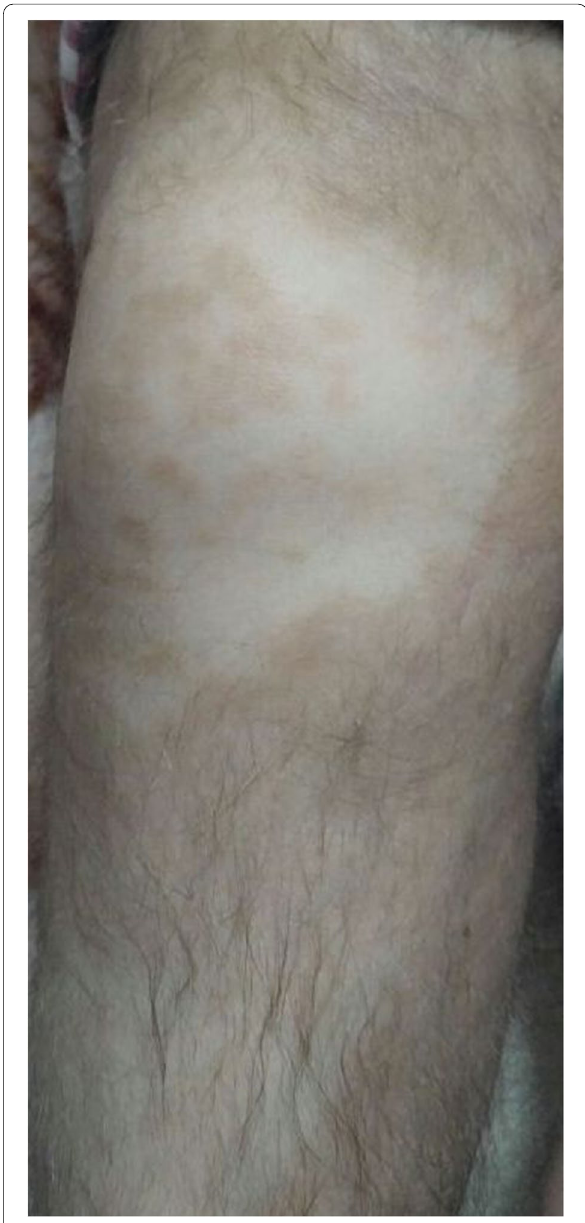
Fig. 1 The child’s leg showing hyperpigmentation and